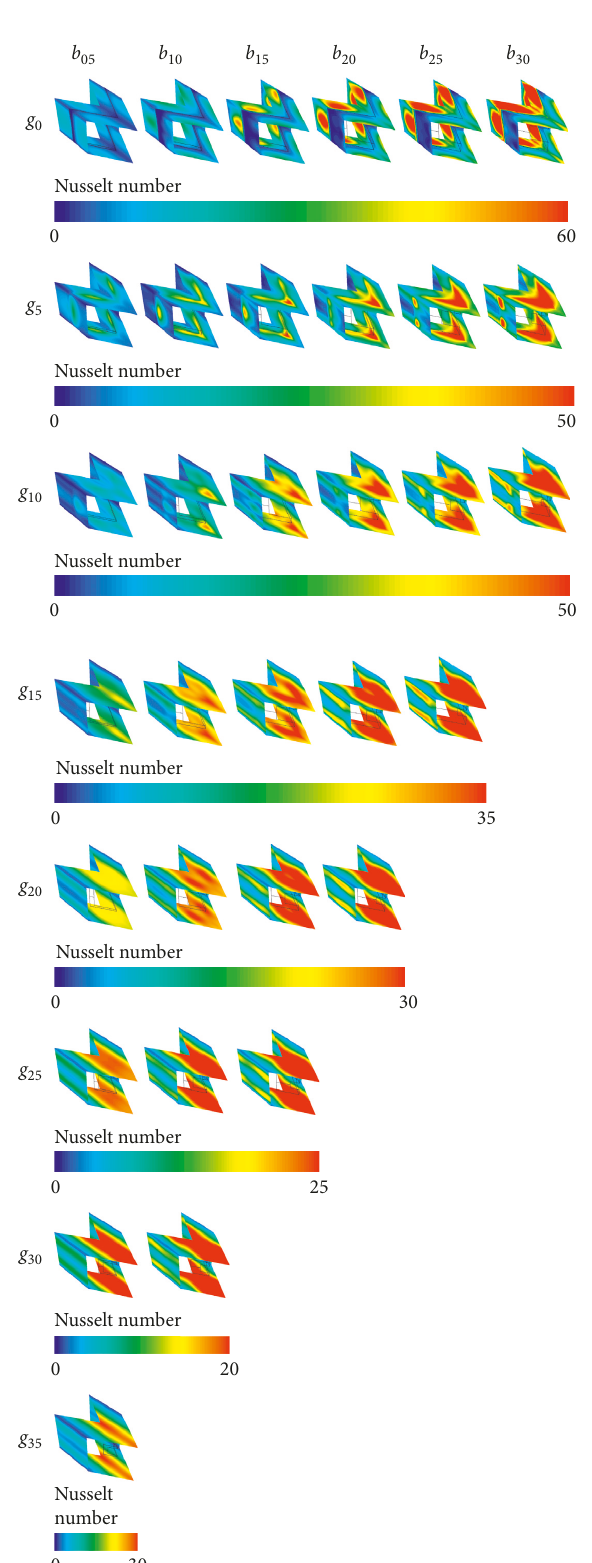
Figure 6: Local Nusselt number distribution on the channel walls for the square channel heat exchanger installed with V-orifice at various blockage ratios and gap spacing ratios for Re � 800 and V- downstream